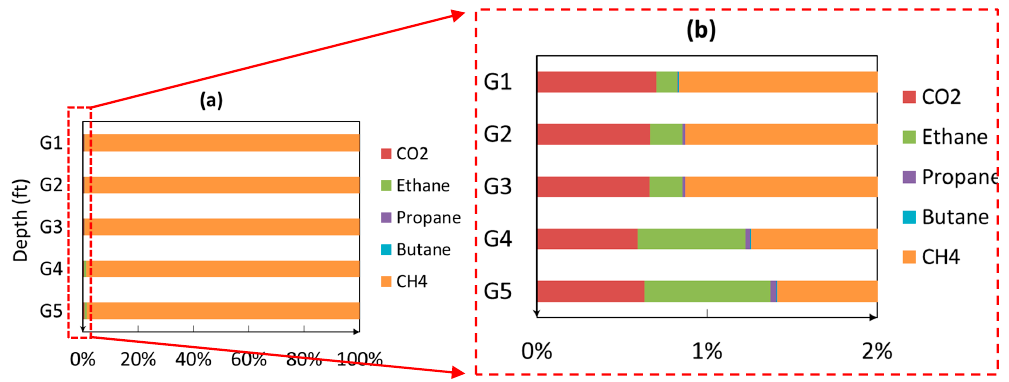
Figure 6. Gas composition for each coal seam interval at different depths: ( a ) Gas composition for each coal seam interval at different depth, and ( b ) represents an enlarged section of Figure 6a.